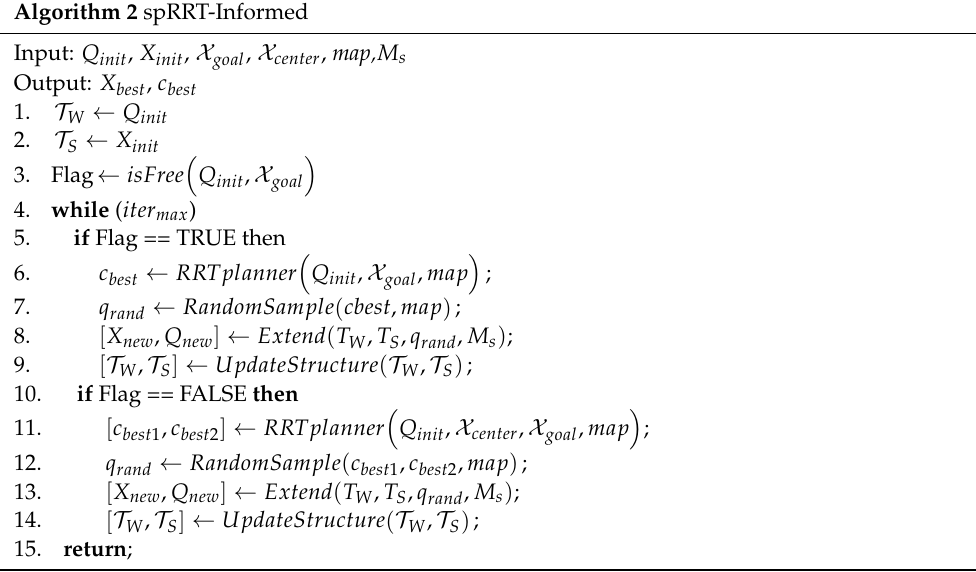
Algorithm 2 Algorithm 2 spRRT ‐ Informed